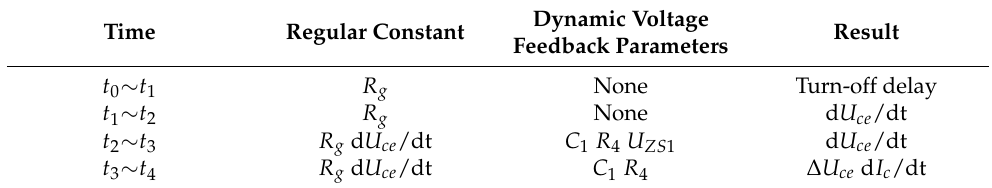
Table 1. Influence of parameters on turn-off characteristics at various stages. Time Regular Constant